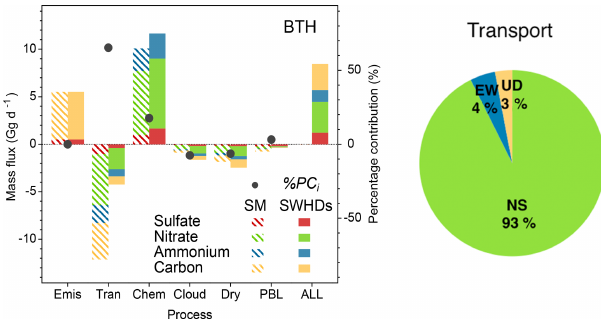
Figure 9. Daily mean mass fluxes of aerosols by physical–chemical processes (bottom axis: emission, transport, chemistry, cloud pro- cesses, dry deposition, diffusion, and the sums) in the BTH box. Two kinds of averages are given here: averaged over all days during winters from 1985 to 2017 (PC SM , left stripped bars) and averaged over all SWHDs during this period (PC SWHD , right solid bars). Black dots give the relative contributions (%PC, right axis) of each of the six processes i (unit: %) for the SWHD formation when com- pared with mean values. The %PC i is calculated following Eq. (1). The pie chart presents the relative contributions made by three wind components: north–south (NS), east–west (EW), and up–down (UD) for the transport difference (PC_ SWHD_tran − PC_ SM_tran ). Note that carbon here refers to the carbonaceous aerosols, which is the sum of black carbon and organic